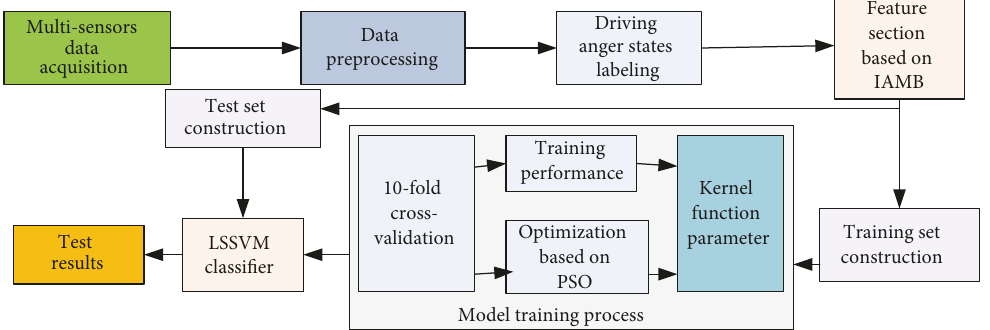
Figure 4: The modeling process of LSSVM with